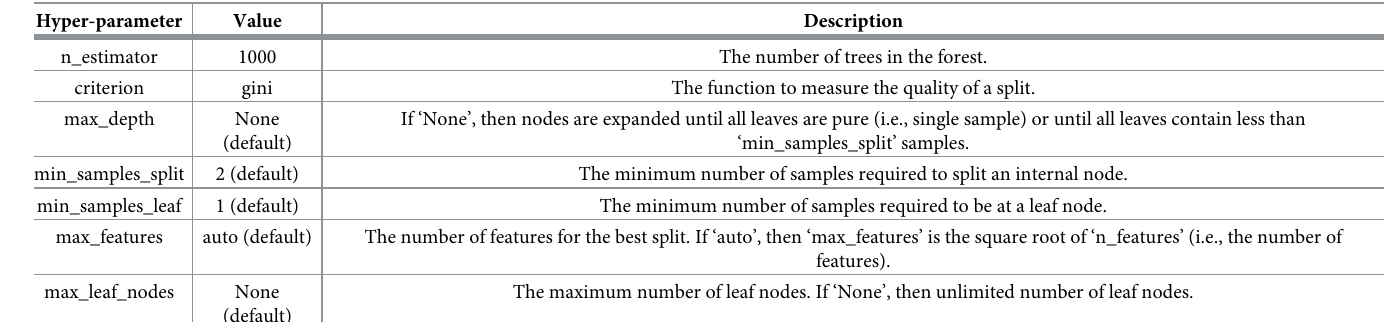
Table 2. The hyper-parameters used in our proposed Random Forest model provided by scikit-learn framework. Hyper-parameter Value Description